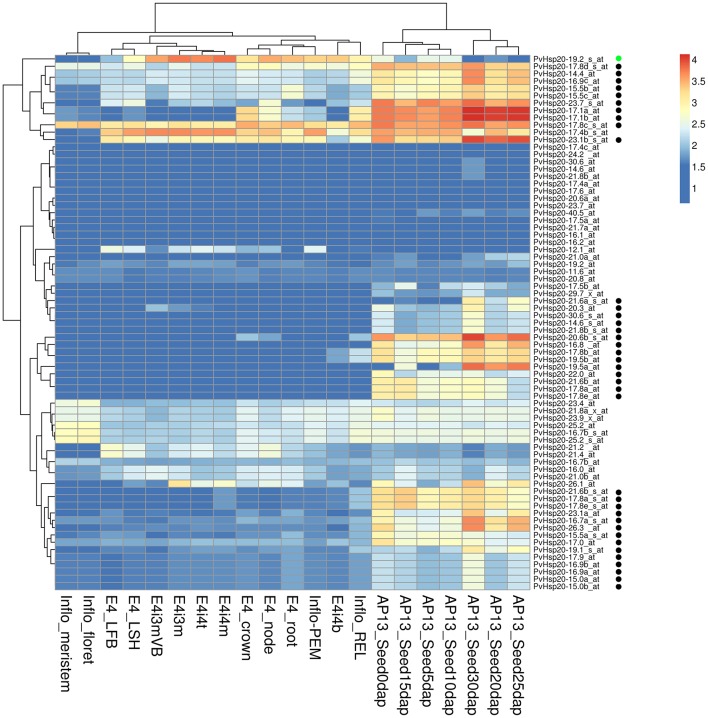
Heatmap of expression patterns of sHsps in 21 organs, tissues or at different developmental stages. E4-root, E4-crown, E4-node, E4-LFB, and E4-LSH indicate whole root system, whole crown, pooled nodes, pooled leaf blade from plant, and polled leaf sheath, respectively. E4i3m and E4i3mVB mean Middle 1/5 fragment of the 3rd internode and vascular bundle isolated from 1/5 fragment of the 3rd internode. E4i4b, E4i4t, and E4i4m indicate bottom 1/5 fragment of the 4th internode, top 1/5 fragment of the 4th internode, and middle 1/5 fragment of the 4th internode 4. Inflo-meristem, Inflo-floret, Inflo-REL, and Inflo-PEM indicate inflorescence meristem (0.5–3.0 mm), floret of inflorescence when glumes are 10–20 mm, rachis and branch elongation of inflorescence (50–150 mm), and panicle emergence of inflorescence (>200 mm), respectively. AP13_Seed0d, AP13_Seed5d, AP13_Seed10d, AP13_Seed15d, AP13_Seed20d, AP13_Seed25d, AP13_Seed30d represent whole flowers at anthesis stage, whole seeds 5 days post fertilization, whole seeds with visible caryopsis, whole seeds at the milk stage, whole seeds at the soft dough stage, whole seeds at the hard dough stage, whole seeds at the physiological maturity stage, respectively. The black and green circles besides each gene name indicate these genes were specifically expressed in seed developments and lignified tissues, respectively.